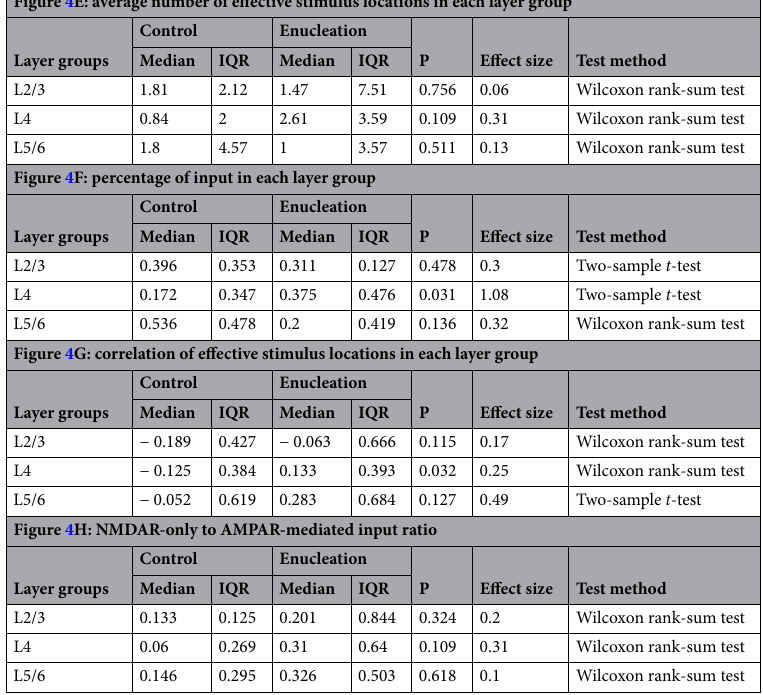
Figure 4E: average number of effective stimulus locations in each layer group